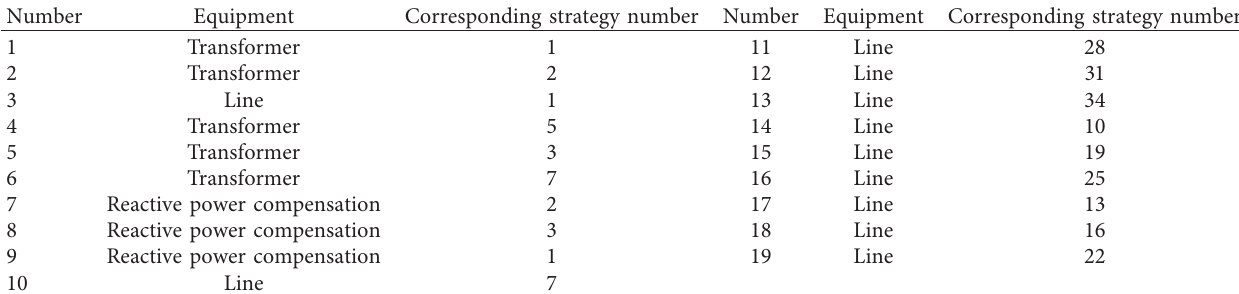
Figure 9: Cost-benefit calculation results of individual loss reduction strategies (reactive power compensation). Table 7: Details of the individual optimal loss reduction strategies after